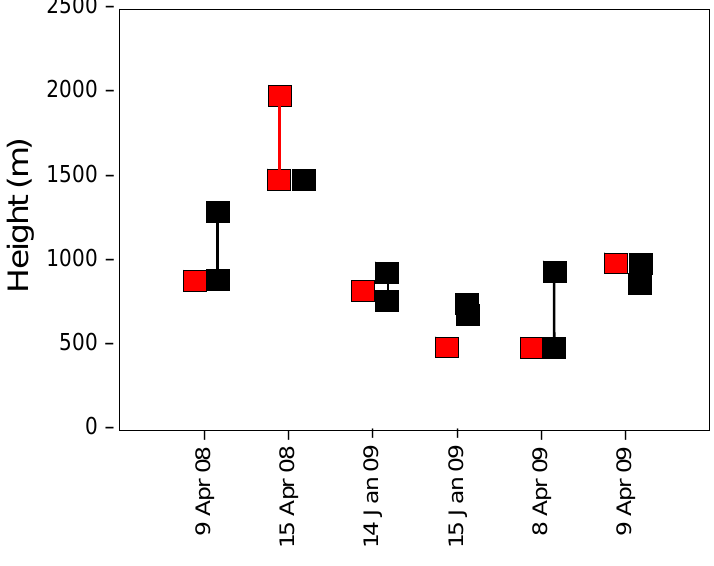
Figure 15. Plume heights for Daysmoke-simulated plumes (red squares) compared with plume heights observed by ceilometer (black squares) for six prescribed burns at Fort